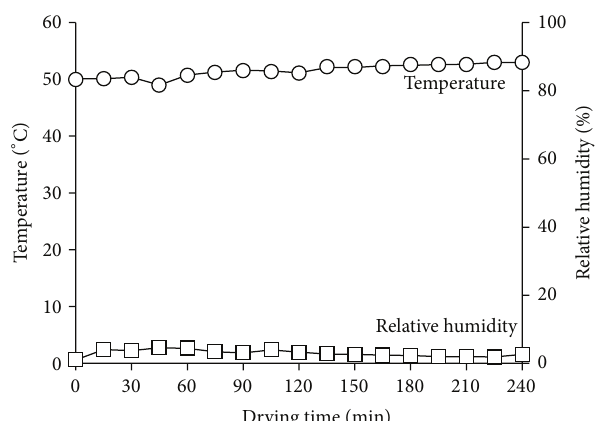
Figure 1: Representative example of change in temperature and relative humidity during wood